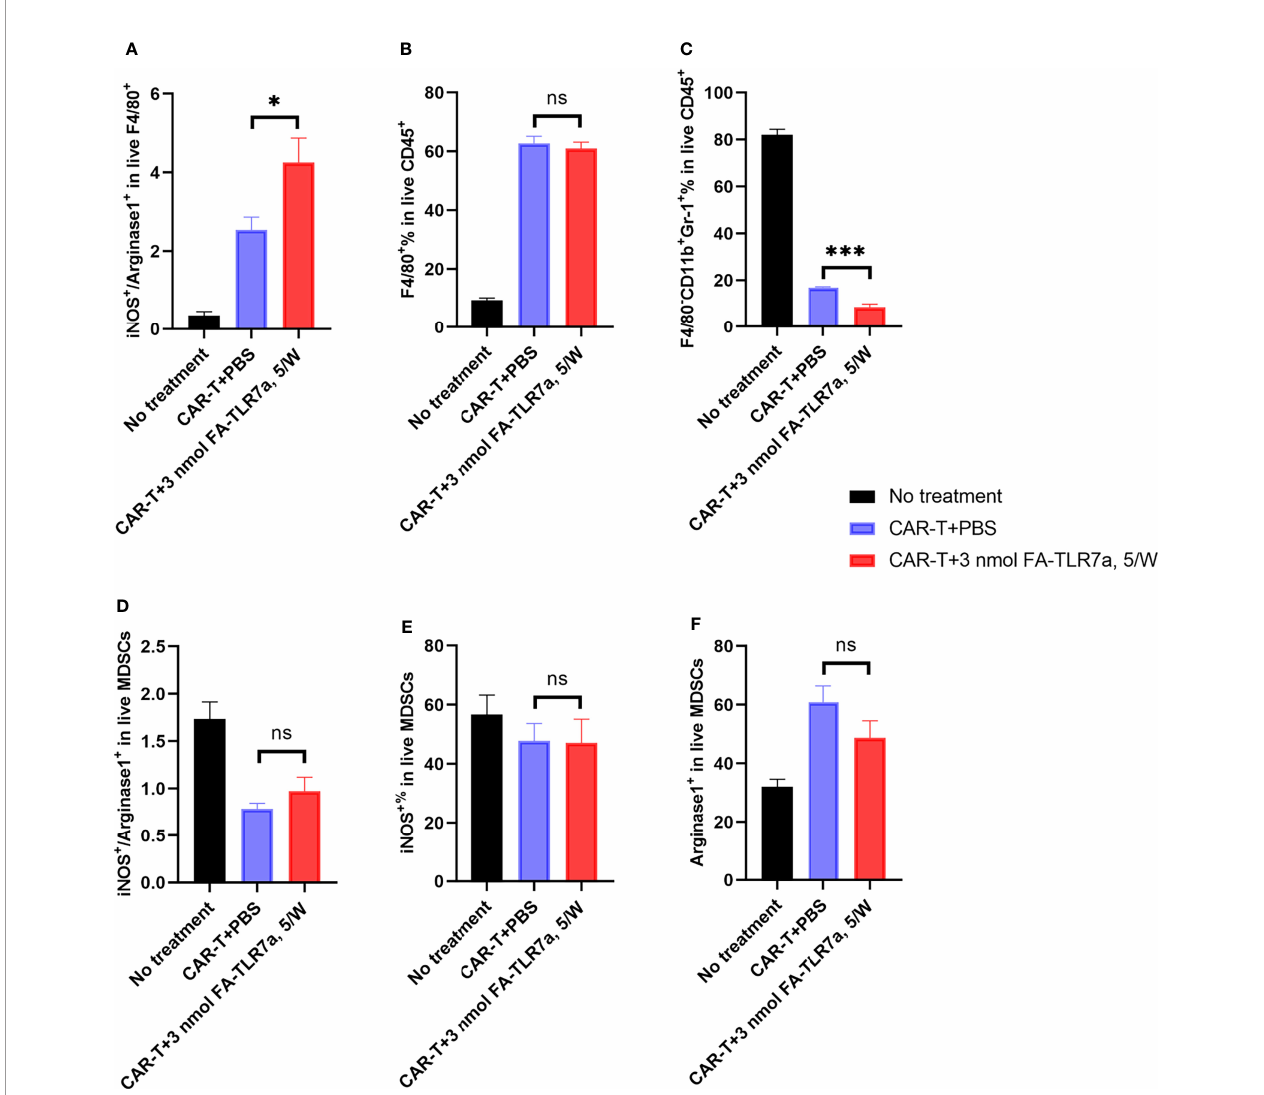
FIGURE 5 | Impact of CAR T cells and FA-TLR7-1A on the properties of tumor in fi ltrating TAMs and MDSCs. (A) Estimation of the M1:M2 ratios of F4/80 positive macrophages within the solid 4T1-mCD19 tumors following treatment with the indicated therapies. The ratio of inducible nitric oxide synthase (iNOS) to arginase 1 (Arg 1) was used as an estimate of M1-like to M2-like macrophages. (B) Percentage of live CD45 + cells in the solid tumors that were F4/80 positive macrophages. (C) Percentage of MDSCs in live CD45 + cells in the solid tumors. (D) Ratio of the iNOS + to Arg 1 + population among live MDSCs. (E) Percentage of the iNOS + population in live MDSCs. (F) Percentage of Arg 1 + population in live MDSCs. This study was performed three times with similar results each time. The number of mice/group is the same as reported in the legend to Figure 3 , except in the CAR-T + 3 nmol FA-TLR7-1A, 5/W group only 5 of 9 tumors could be analyzed because 4 of 9 mice experienced complete cures. Mean ± SEM. Statistical signi fi cance was determined using an unpaired two ‐ tailed t ‐ test (*P < 0.05, ***P < 0.001, ns, not signi fi cant P ≥